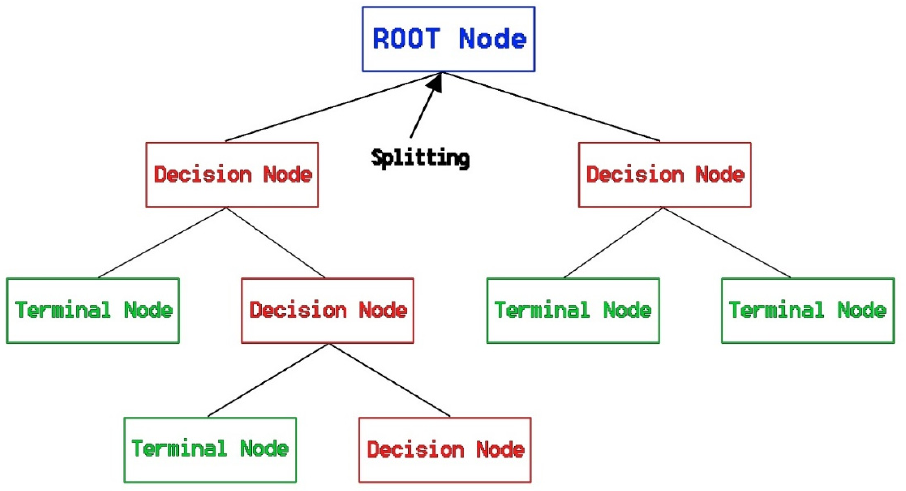
Figure 3. The decision tree can be pruned by nodes in classification and regression trees (CART).